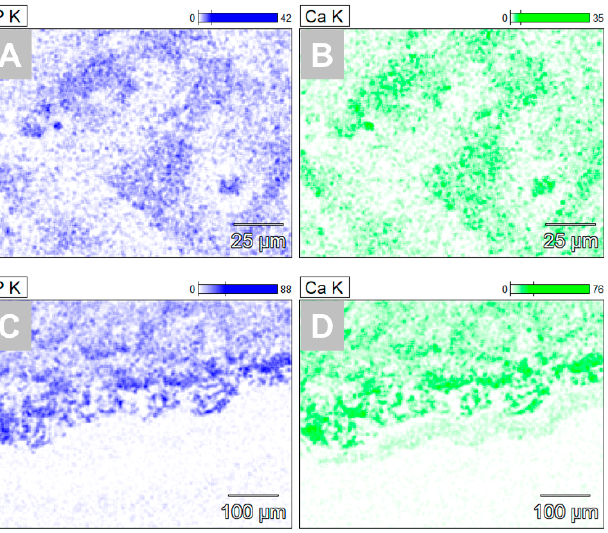
Figure 6. Exemplary SEM-EDX visualization of calcium (Ca) and phosphate (P) within the VH-A implantation beds at day 30 post implantation. ( A ) and ( C ) Phosphate presence, ( B ) and ( D ) calcium presence within the region of the implanted hydrogel up to the borders of the implantation beds (magnifications = 500 × , scalebars = 100 µm).